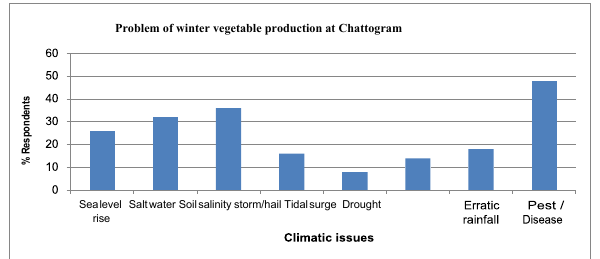
Figure 12: Farmers response on impacts of climate change on winter